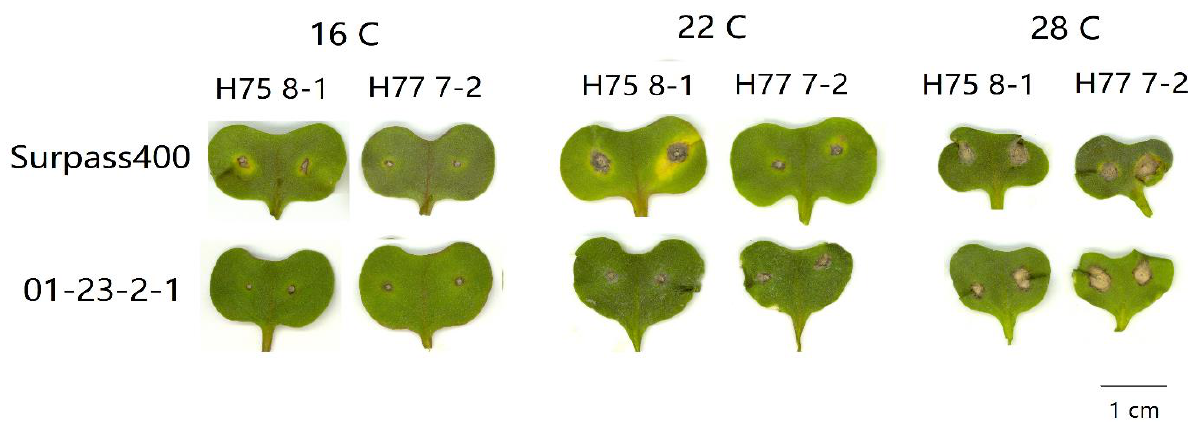
Figure 1. Lesion development from six pairs of Brassica napus cotyledon– Leptosphaeria maculans isolate inoculation: Surpass400–HCRT75 8-1/HCRT77 7-2 and 01-23-2-1–HCRT75 8-1/HCRT 77 7-2 at 11 days post-inoculation (dpi) with three temperature treatments: 16 ◦ C/10 ◦ C, 22 ◦ C/16 ◦ C, and 28 ◦ C/22 ◦ C (day/night: 16 h/8 h). Bar = 1cm.